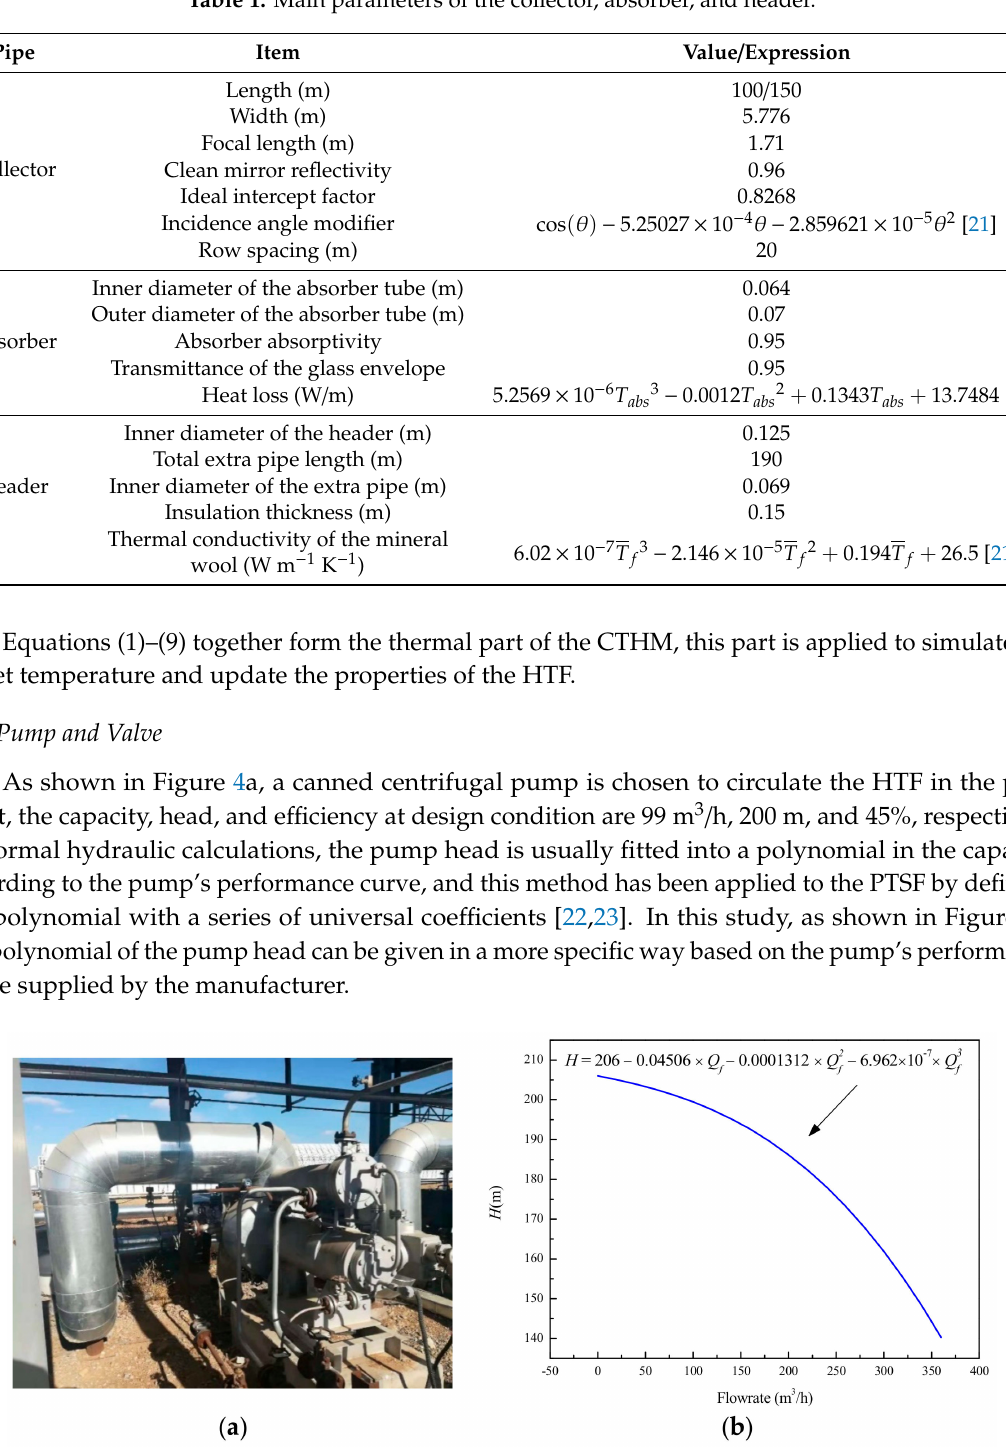
Table 1. Main parameters of the collector, absorber, and header.